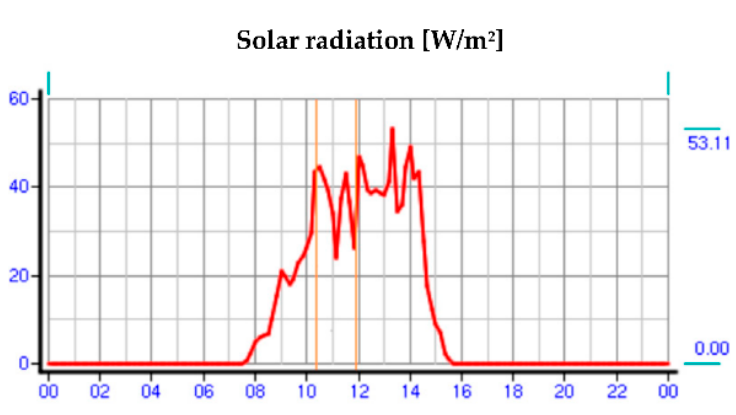
Figure 5. Precipitation and wind speed values on the day of the study (source: authors).